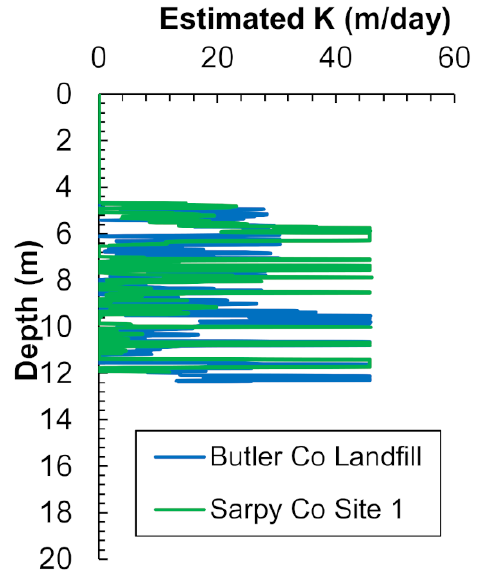
Figure 8. Estimated hydraulic conductivity changes with